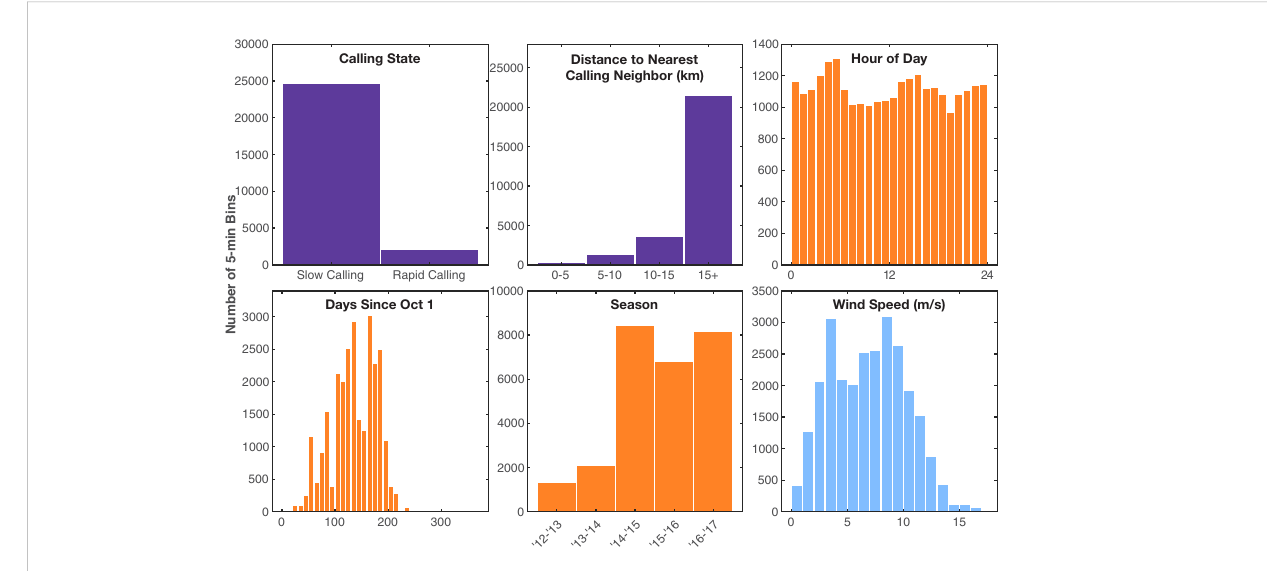
FIGURE 6 Histograms of the independent variables observed during minke whale tracks. The y-axis counts are the number of 5 min bins. Minke behavioral variables are shown in purple, time variables are shown in orange, and the environmental variable is shown in blue. Hour of day is in local Hawaii Standard Time.